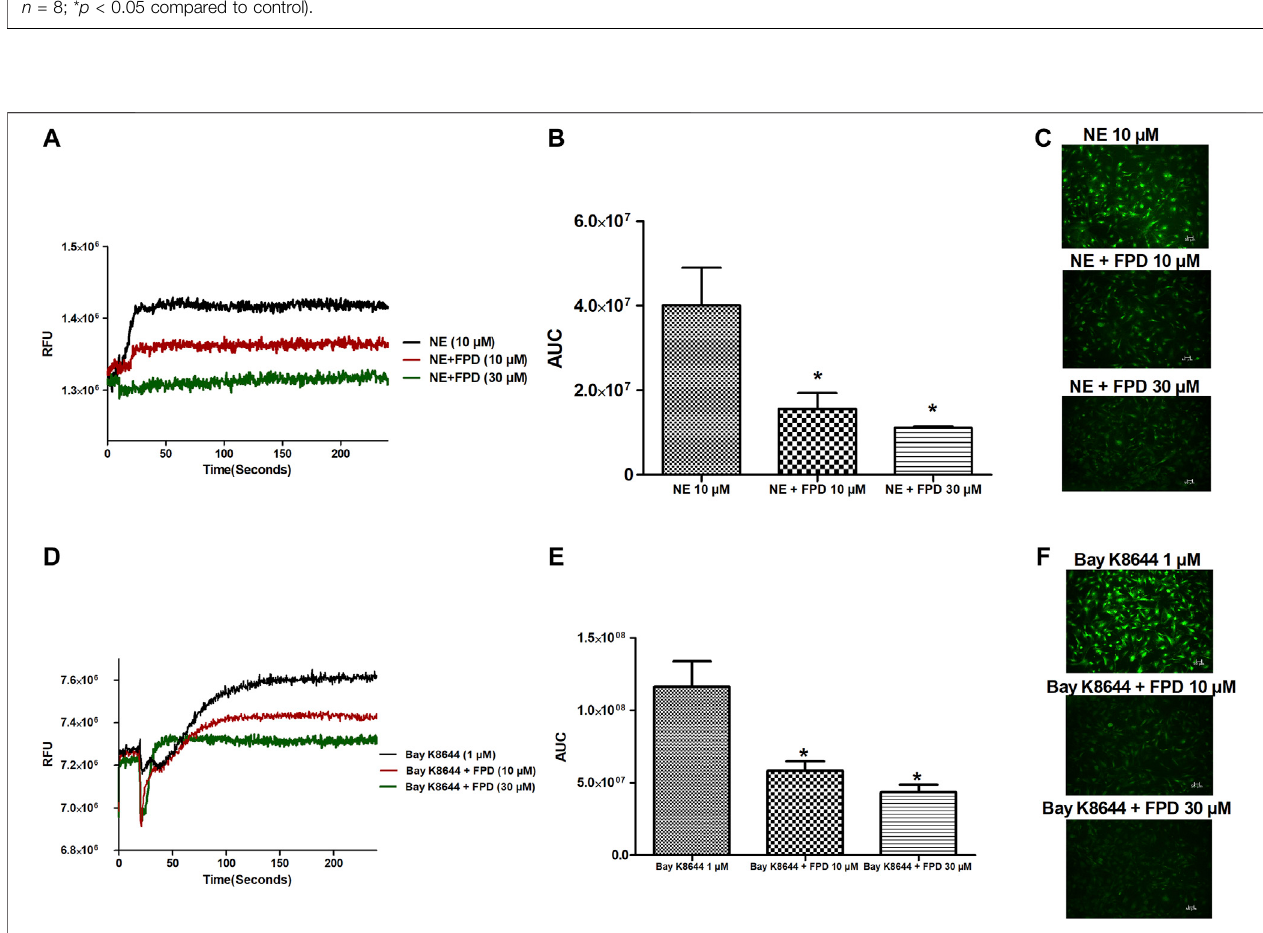
FIGURE9| Representativetraces ofcytosolic Ca 2+ concentration ([Ca 2+ ] i ) stimulated byNE (10 µM), Bay K8644 (1 µM) alone, and inthe presence ofFPD (10 and 30 µM) in rat aortic VSMC loaded with Fluo-4 (A, D) ; area under the curve (B, E) (AUC, * signi fi cantly decreased compared to NE/Bay K8644 treated cells; n (cid:2) 10); representative images of the cells (C, F)